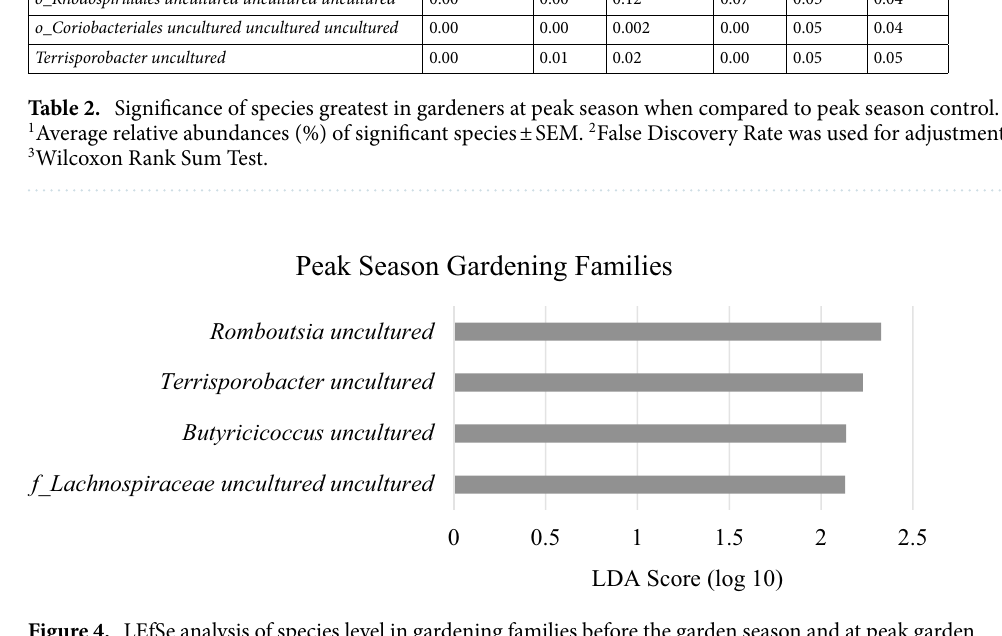
± 45.0, peak: 175 ± 43.6; p = 0.6) (Fig. 2A) and Faith’s PD (baseline: 11.5 ± 2.7, peak: 12.3 ± 3.0; p = 0.3) (Fig. 2B). Beta diversity distance metrics were not different across the gardening season in gardening families, including weighted (p = 0.98) and unweighted UniFrac (p = 0.99), Bray–Curtis (p = 0.88), and Jaccard (p = 0.96) (Supple- mentary Figure S5). At the species level, LEfSe analysis revealed that gardening families had significantly greater abundances of Romboutsia uncultured, Terrisporobacter uncultured, Butyricicoccus uncultured, an uncultured genus in the Lachnospiraceae family at peak season than before the gardening season (Fig. 4). Over this time period, Romboutsia increased 77% (p = 0.03) and Terrisporobacter increased sixfold (p = 0.01) (Fig. 5). Fast expectation–maximization for microbial source tracking (FEAST) 25 was utilized to investigate the poten- tial origin of fecal microbes by using respective gardening plot soil samples as sources of taxa. Results revealed a contribution of soil endemic microbes into the gut of gardening families, suggesting a taxon movement (Fig. 6). Average proportions of shared soil microbiota increased across the gardening season (p = 0.03). Eight of the nine